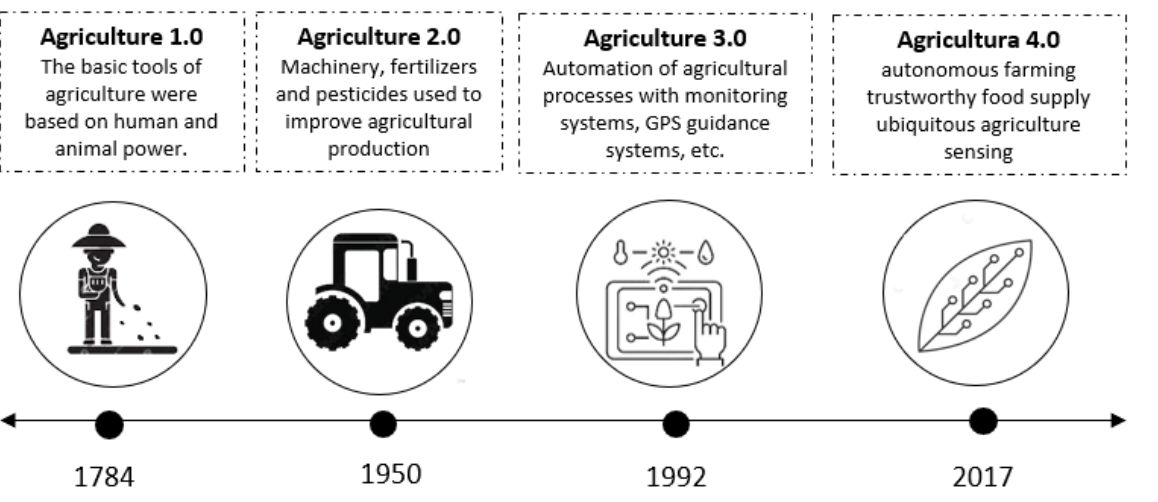
Figure 1. Timelines of agricultural revolutions (based on [10]). As agriculture is one of the most important economic pillars in the economy of countries, it needs to adopt new technologies such as PA, which apply inputs in the right place at the right time [11]. In this context, large economies around the world